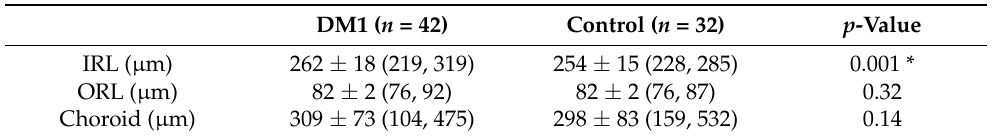
Table 2. Mean layer thickness of inner retinal layer (IRL), outer retinal layer (ORL), and choroid. Standard deviation and range are also indicated. Independent t -test was applied for comparison between DM1 ( n = 42) and control ( n = 32) groups.